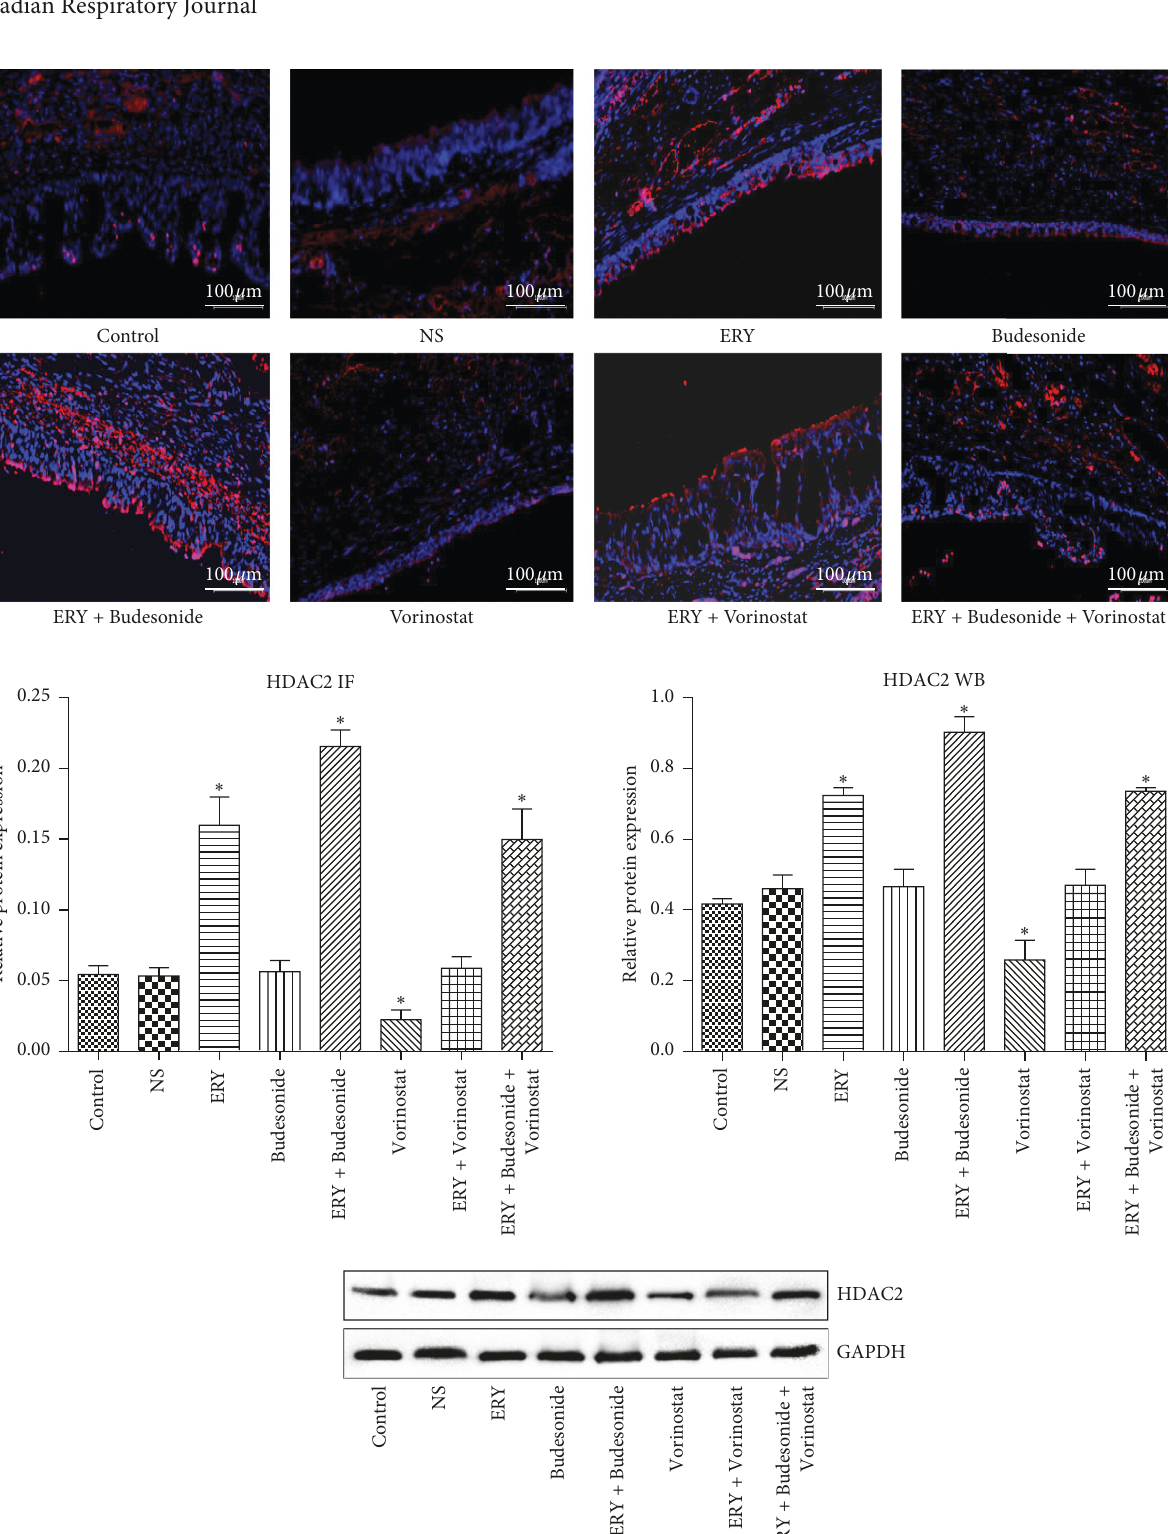
Figure 3: The expression of HDAC2 in the different groups determined by immunofluorescence. Image scale bar, 100 µ m. Red fluorescence (Cy3 staining) for the detection of the target protein HDAC2, blue fluorescence (DAPI staining) for the nucleus. Data are presented as the mean ± standard deviation in the corresponding histogram. ∗ P < 0 . 05 vs. the control group. Control: rabbit tracheal stenosis model without treatment; NS: rabbit tracheal stenosis model treated with penicillin; ERY: rabbit tracheal stenosis model treated with erythromycin; Budesonide: rabbit tracheal stenosis model treated with budesonide; Vorinostat: rabbit tracheal stenosis model treated with vorinostat. HDAC2, histone deacetylase-2; IF,